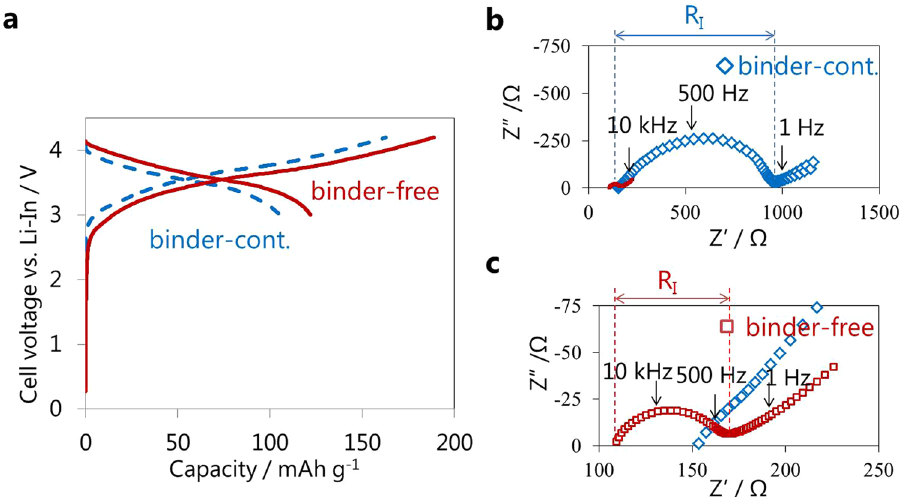
Figure 5. Efficacy of the removal of PPC from full-cells. ( a ) Initial charge-discharge curves of binder- free and binder-containing full-cells, (NCM:f-LPS:AB:PPC = 80:20:2:3)/(LPS:PPC = 100:3)/(graphite:f- LPS:AB:PPC = 58:42:1:3) operated at a current density of 0.064 mA cm − 2 with a cut-off voltage of 4.2–3.0 V and ( b , c ) the corresponding impedance plots measured after charging to 4.2